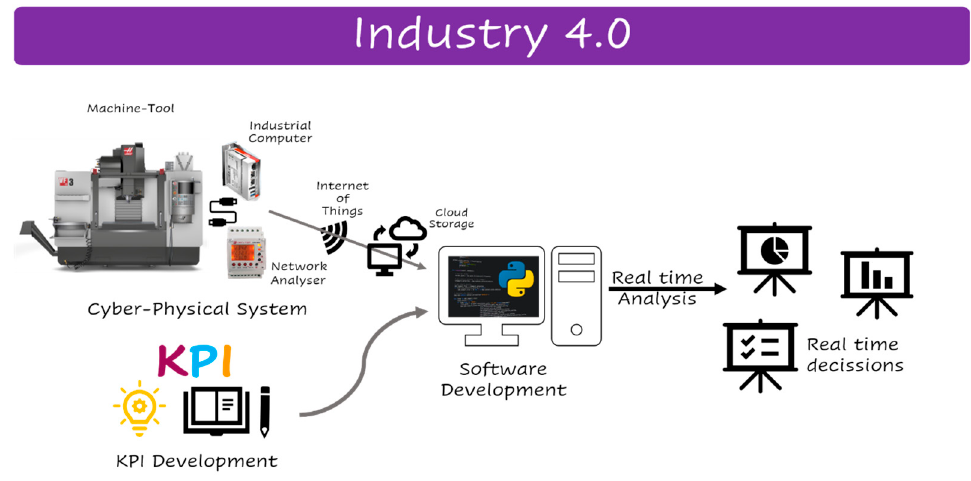
Figure 3. Cyber Physical System (CPS) implementation to data acquisition.